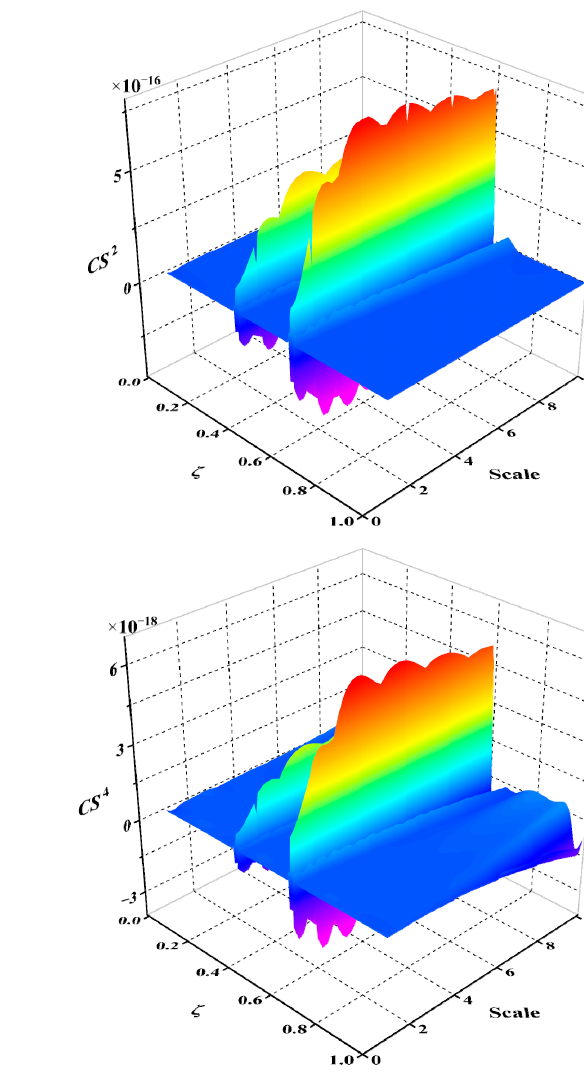
Figure 14. CS ( b, s ) of the extended SSSM boundary under scenario Figure 14. CS ( b , s ) of the extended SSSM boundary under scenario II.